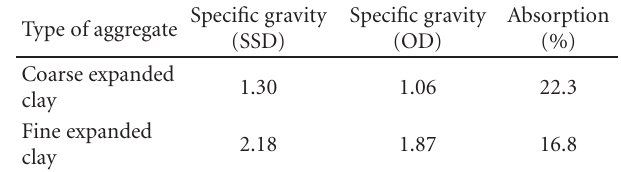
Table 1: Properties of fibers. Table 2: Properties of aggregates.